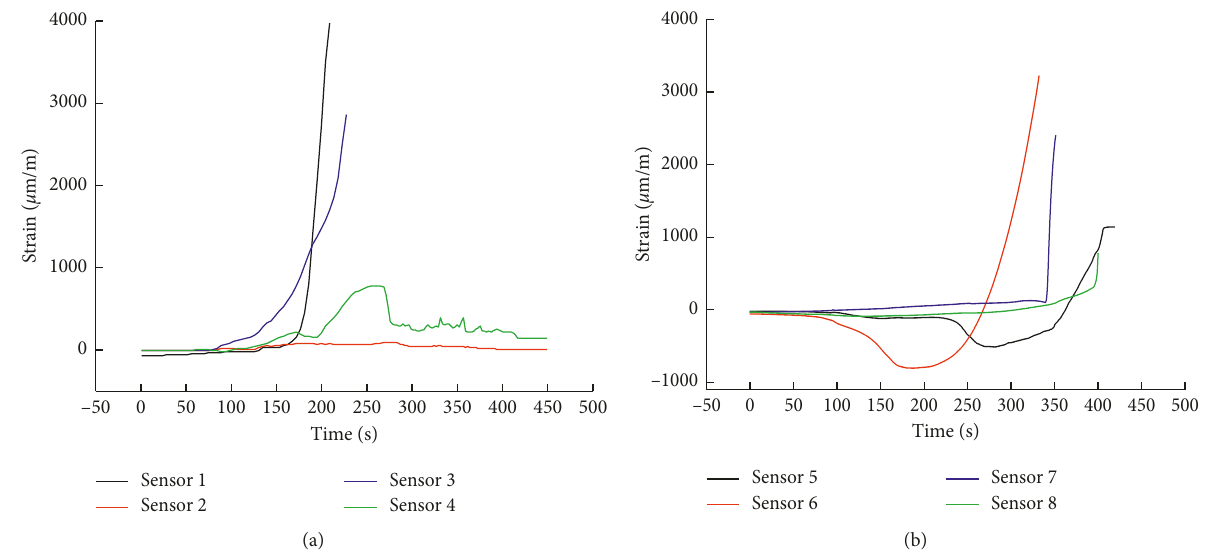
Figure 7: The grating strain-time curve at 40mm from the roadway wall: (a) the strain-time curve of 1–4 FBG sensors and (b) the strain- time curve of 1–4 FBG